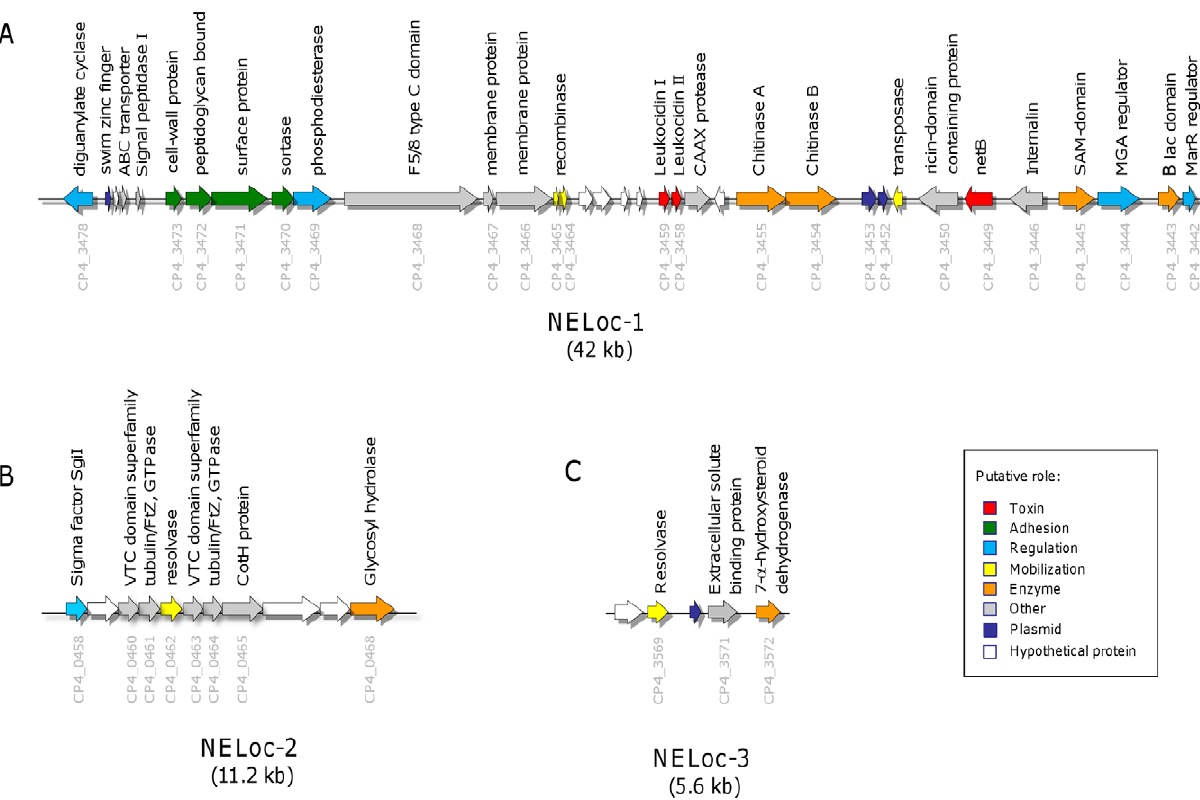
Figure 1. Genetic organization of NE-specific loci. The genetic organization of (A) NELoc-1, (B) NELoc-2 and (C) NELoc-3 is shown, each arrow representing a predicted gene and the total size given below each locus. Predicted functional annotations and locus tags are shown above and below each gene, respectively. Genes are colour-coded by their putative role based upon sequence analyses.